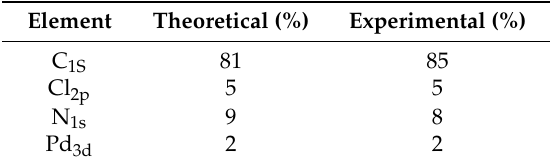
Table 1. Elemental and X-ray photoelectron spectroscopy analysis of complex Calx-IPr.